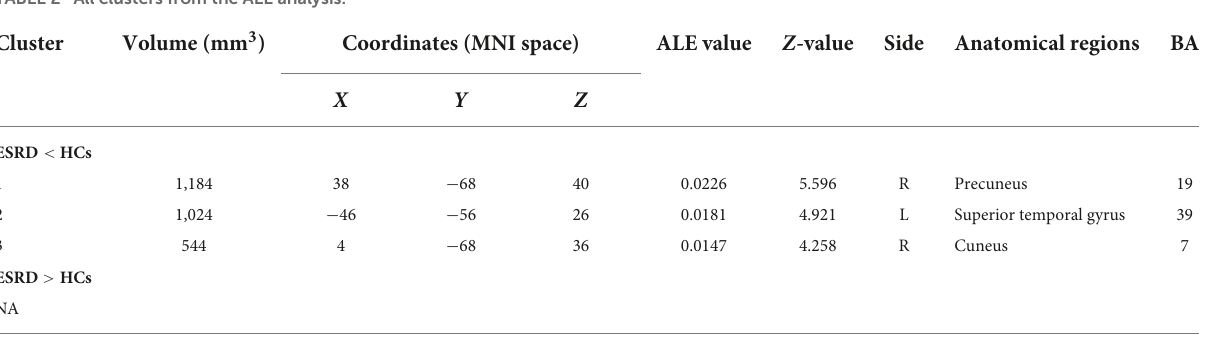
TABLE 2 All clusters from the ALE